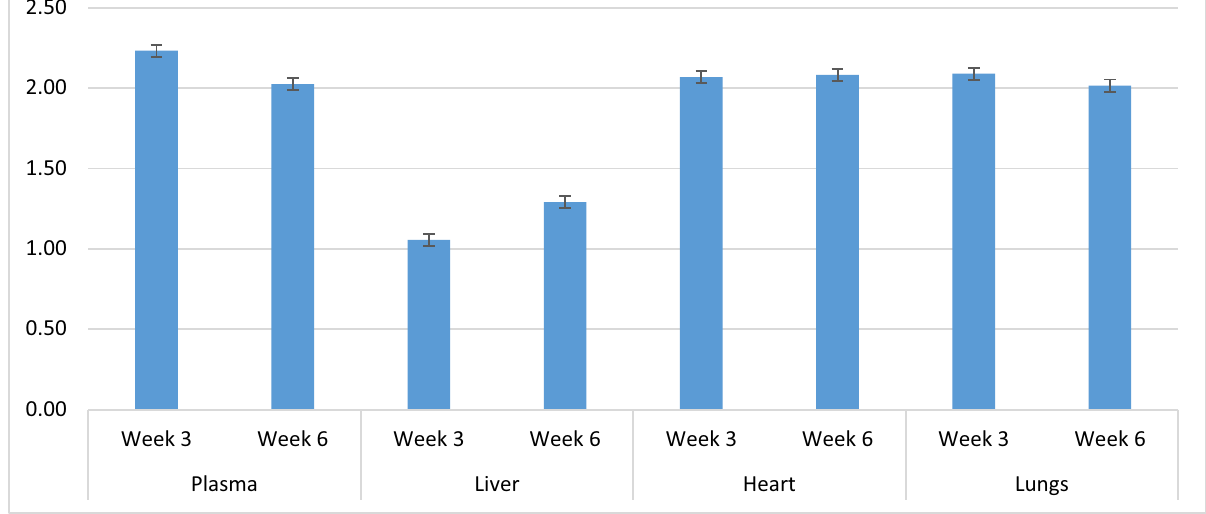
Figure 4. Relative bioavailability of RRR-α-tocopherol in plasma, liver, heart and lungs of mink fed 50, 75, 100 mg/kg of all-rac -α-tocopheryl acetate (SYN). Presented values are LS-means across dose ± SEM. The relative bioavailability of RRR-tocopherol in plasma and tissues was calculated as percentage of a given RRR-tocopherol in plasma and tissues divided by percentage of the RRR-tocopherol in the